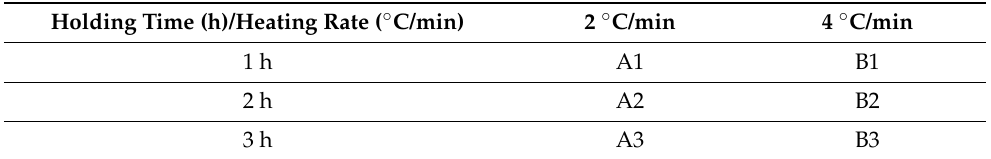
Figure 1. Sintering profile with different heating rate for step 2 ( a ) 2 °C/min and ( b ) 4 °C/min.